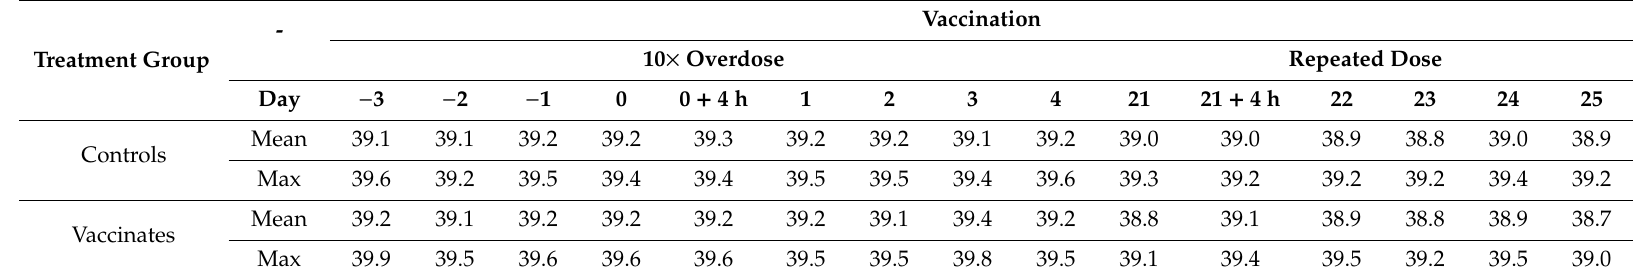
Table 1. Average body temperature ( ◦ C) in New Zealand White (NZW) rabbits per day.